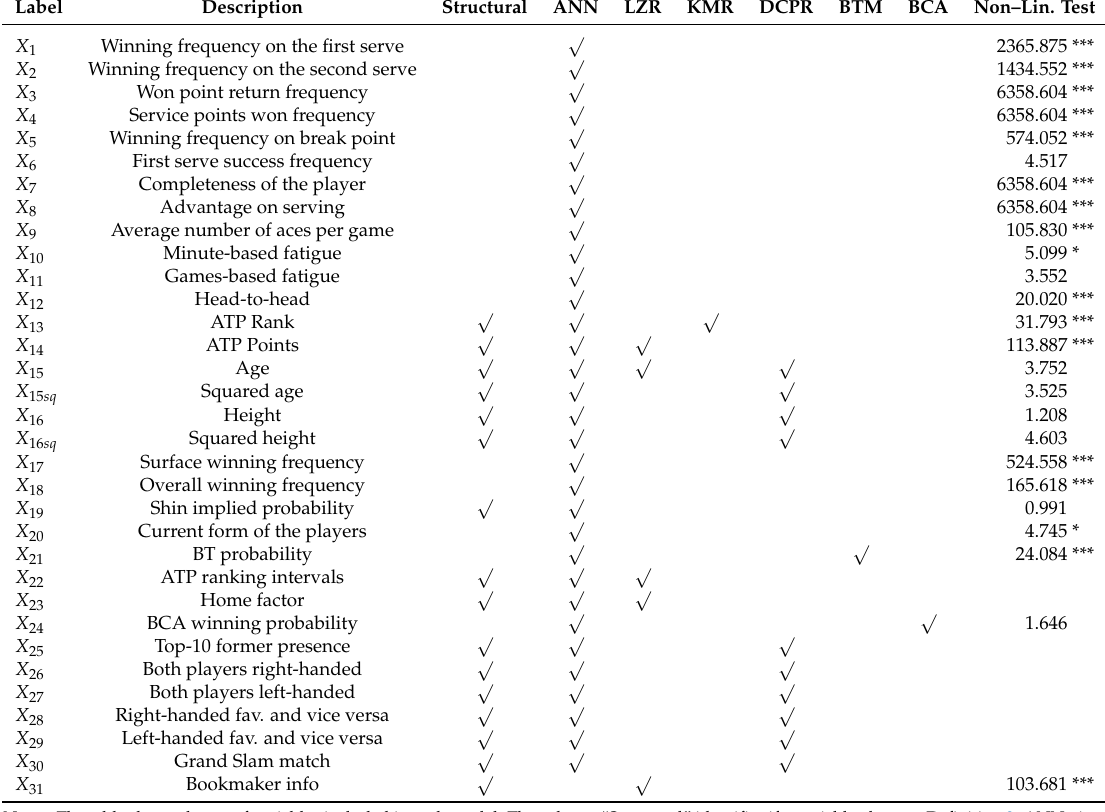
Table 1. Input variables.